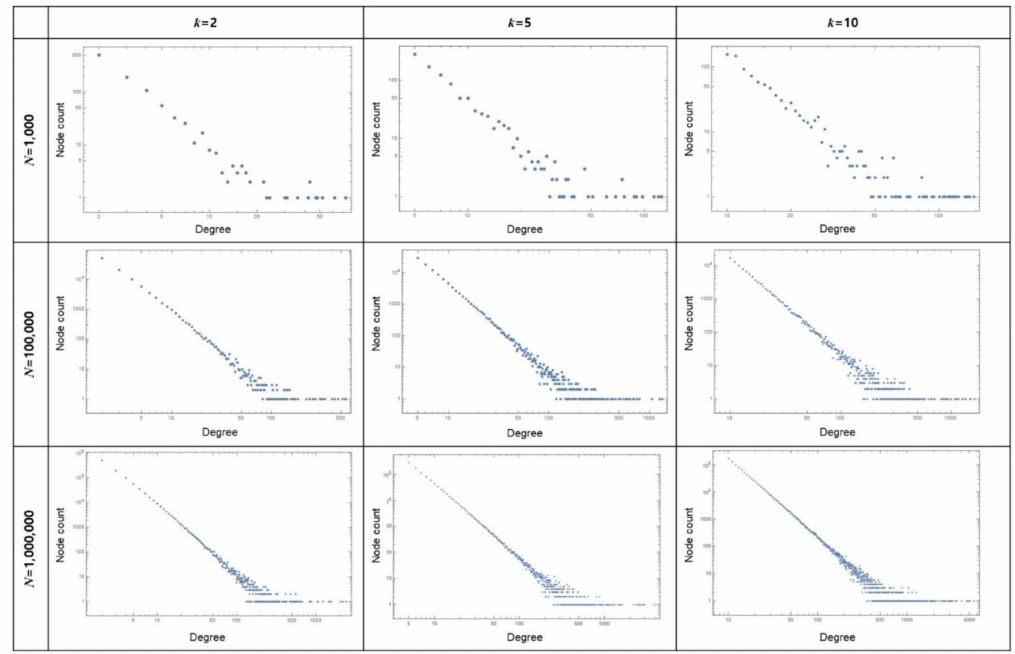
Figure 2. Degree distribution of the scale-free network. We analyzed the degree distribution of the network based on the number of nodes ( N ) and mean degree ( k